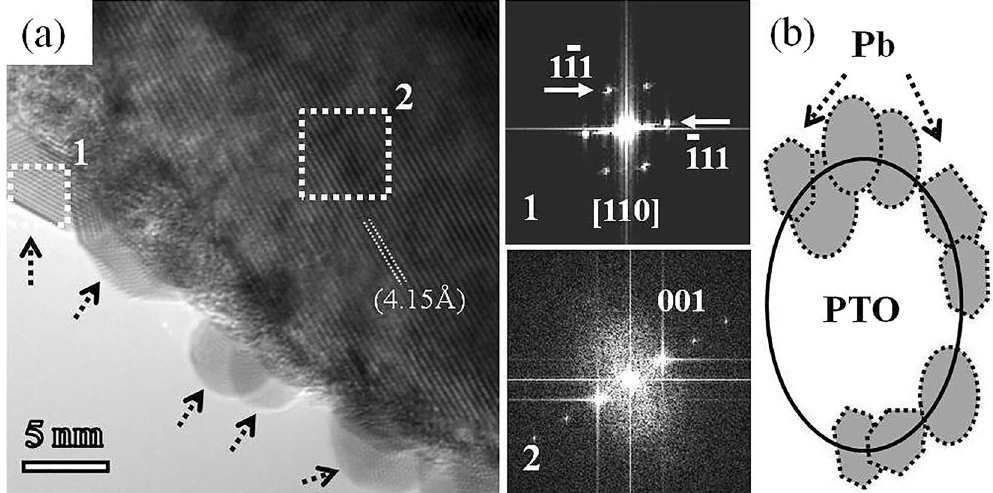
Figure 2. ( a ) HRTEM image of Pb-NPTO nanomaterial. The right side image 1 and 2 are corresponding FFT pattern of Pb and PTO, respectively (Where the selected area shown in ( a ) by white dotted rectangles). ( b ) A model diagram portrays the Pb-PTO coexisting